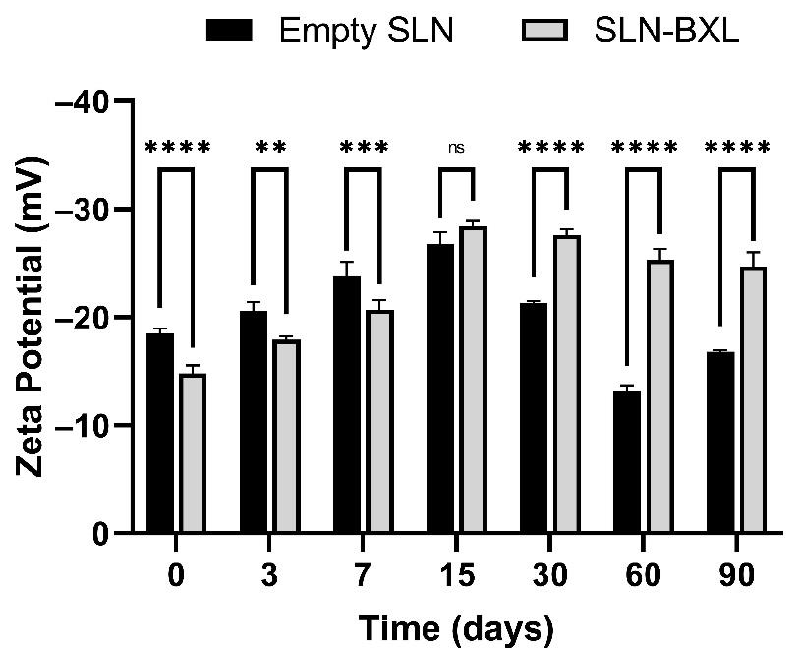
Figure 3. SLN zeta potential. The results are shown as mean ± standard deviation. Confidence intervals calculated by two-way ANOVA: ns = not significant; ** = p < 0.01; *** = p < 0.001; **** = p < 0.0001. Empty SLN exhibit a mean particle size of 165 nm, remain unchanged over the period, while the association with the BXL causes an initial size increase at 300 nm, probably caused by the adsorption [20] of BXL onto the SLN surface, and/or a slow, gradual distribution of the compound into the nanoparticles matrix; after 3 days, the SLN-BXL z-average stabilizes at 220 nm. The mean particle size values are additionally confirmed by PDI values, which are initially high and then stabilize around